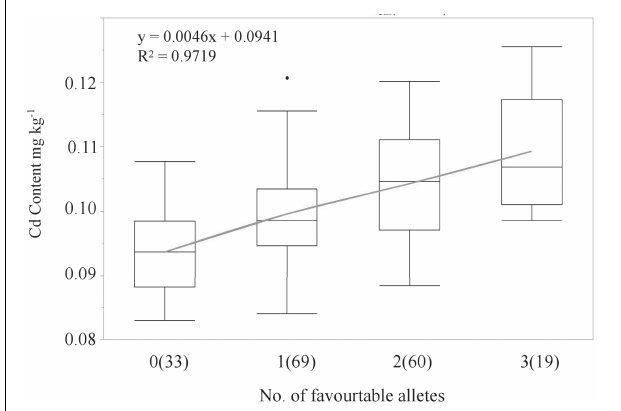
FIGURE 2 | Linear regressions between the number of high Cd alleles (number of lines) and BLUP Cd content in the DH population. Numbers of lines carrying the corresponding number of favorable alleles are shown in brackets. X and Y in the equation represent the number of high Cd alleles and BLUP Cd content, respectively.